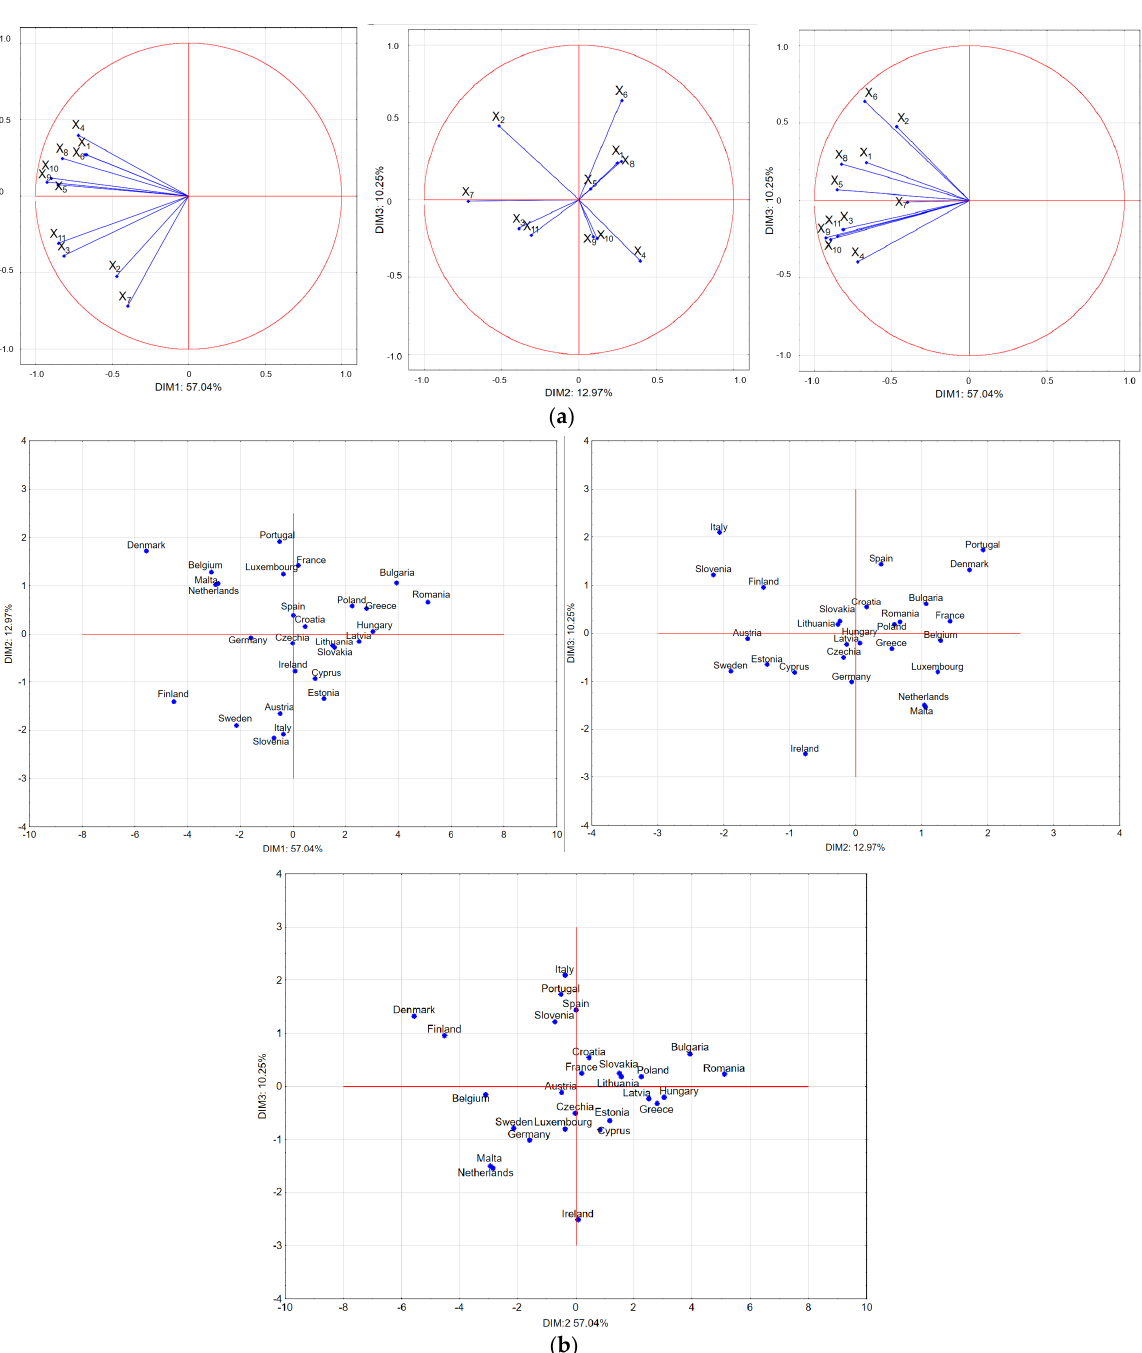
Figure 5. The scatter plot of factor loadings of variables for the first three principal components ( a ) and the scatter plots of countries in the space of three principal components ( b ).